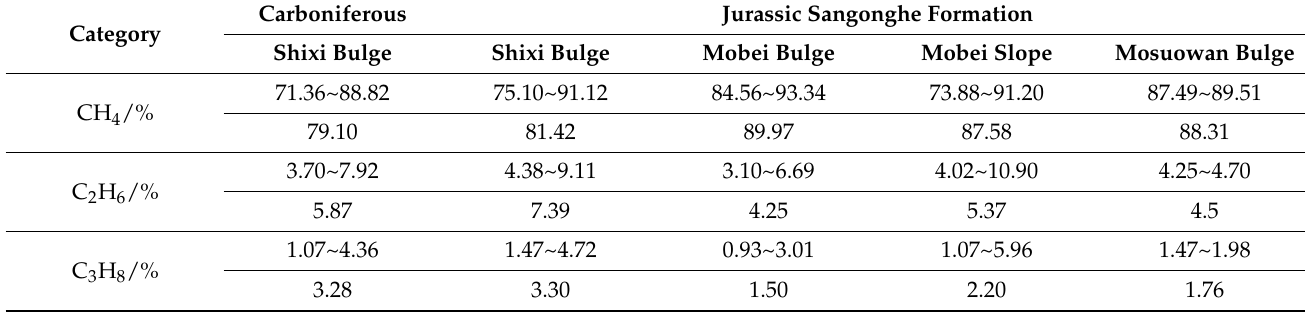
Table 2. Natural gas compositions by zone in the eastern belt around the Penyijingxi sag, Jung- gar